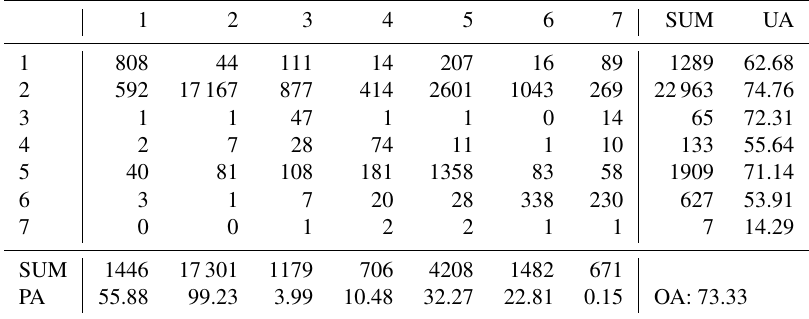
Table B9. Confusion matrix for LANDMATE PFT group 0.9 – the dominant LULC type occupies a minimum of 90% of a LANDMATE PFT grid